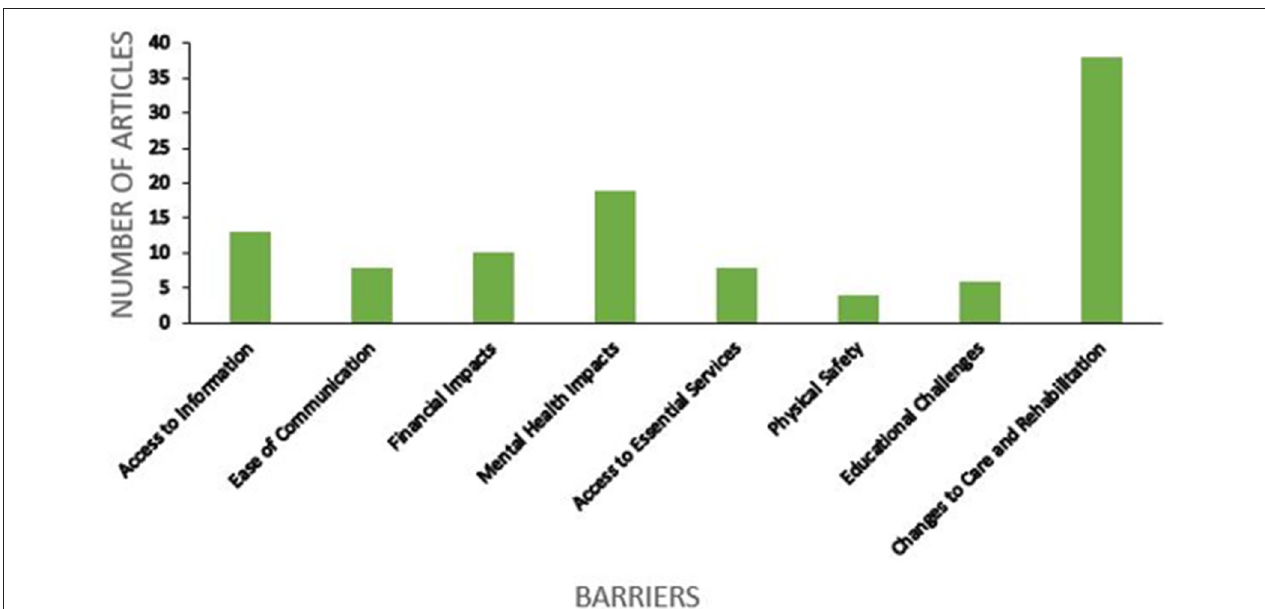
FIGURE 5 | Number of articles per